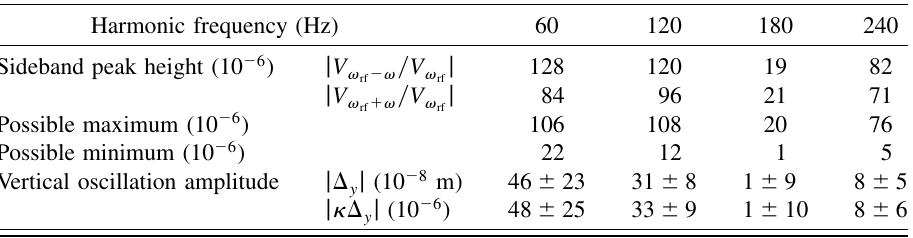
TABLE IV. The measured ratio of sideband peak height to main (carrier wave) peak height in the FFT power spectrum. The estimated vertical oscillation amplitude j (cid:10) (cid:1) the upper and lower limits given by the FFT power spectrum. The errors for j (cid:1) the fitting errors.